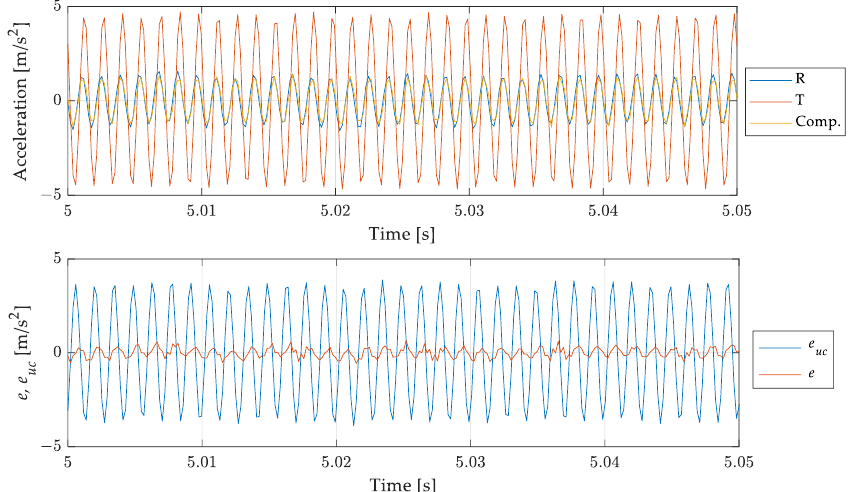
Figure 13. Sinusoidal signal at 700 Hz: comparison of the measurand with the (uncompensated) scaled instrument indication and the compensated measurement result. Short time histories ( top ) and errors for un-compensated 𝑒 𝑢𝑐 and compensated result e ( bottom ).